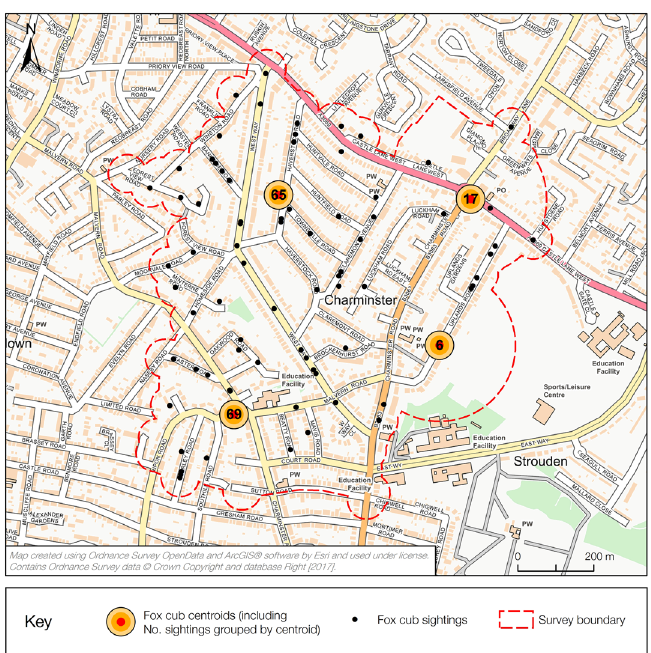
Fig 1. Fox cub centroid integration. An example of the integration method to derive the number of independent fox social groups from cub sightings for one survey site.